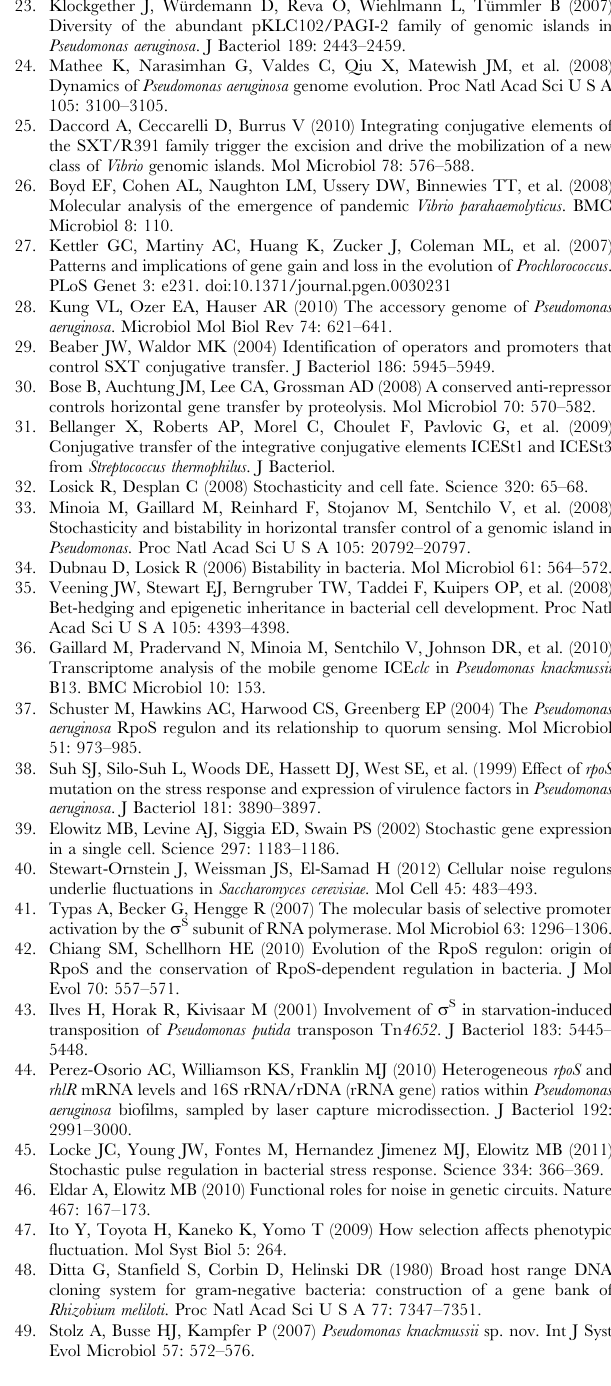
Table S3 Effect of subpopulation size on noise calculation from two identical P int -copies in different places on the chromosome of